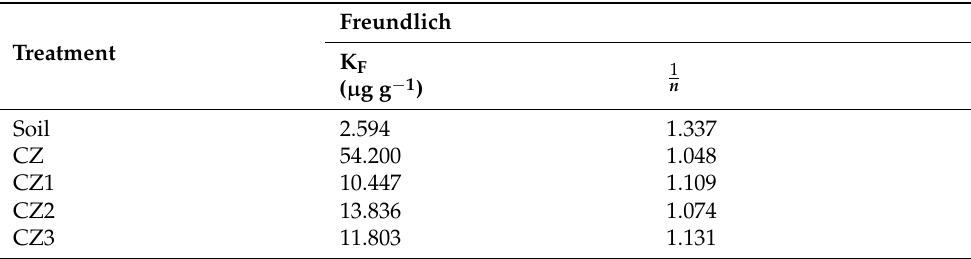
Table 14. Adsorption capacity (KF) and adsorption isotherm constant of Freundlich in relation to adsorption condition (1/ n ) for nitrogen adsorption.